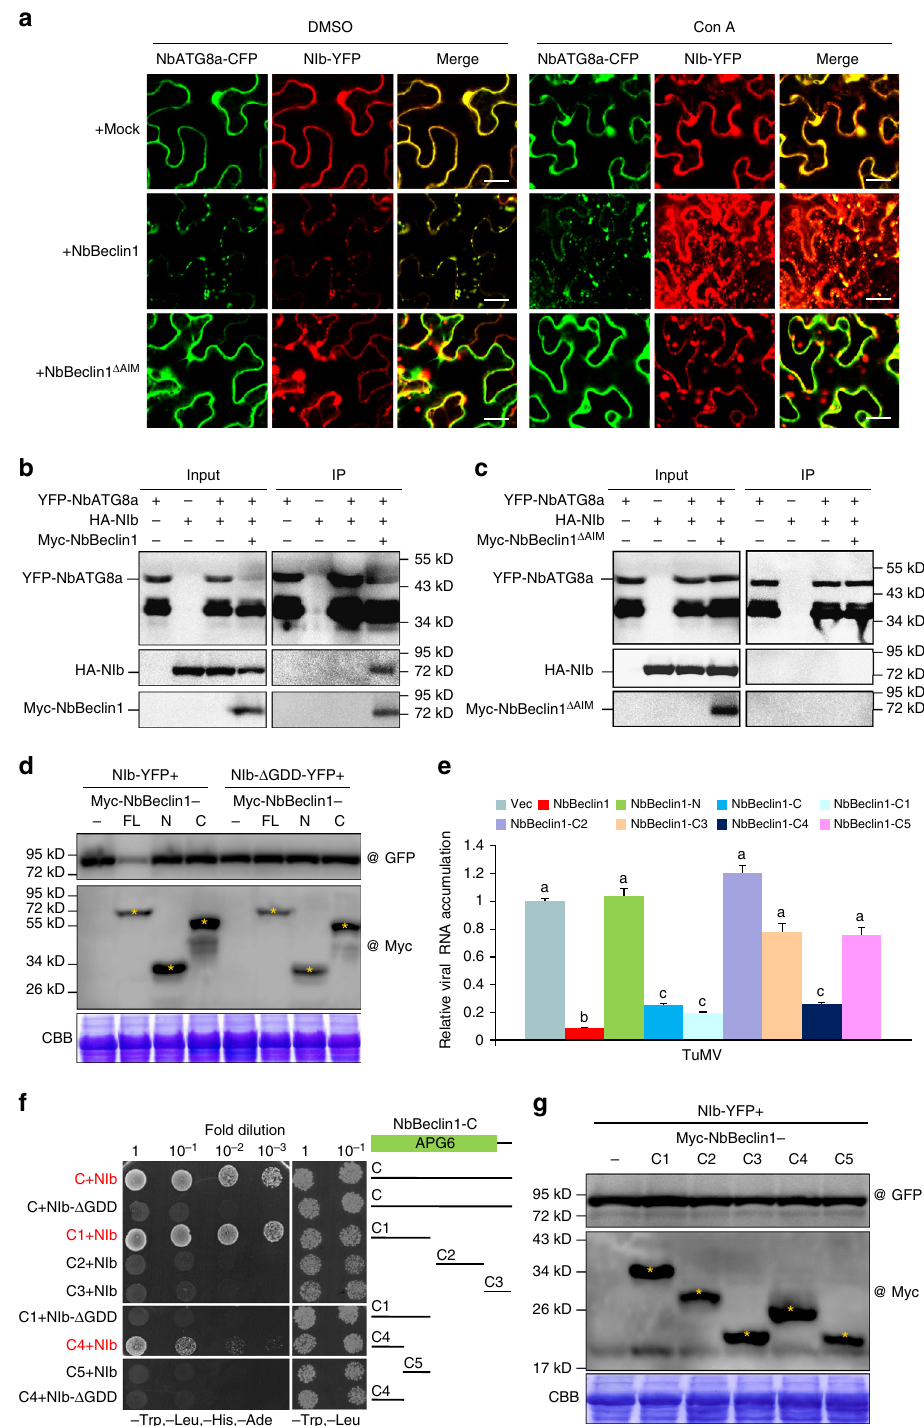
Fig. 7f, the NIb-binding motif was mapped to the N-terminal region (C1) of NbBeclin1-C (strong interaction) or the N- terminal half (C4) of C1 (weak interaction). As expected, both C1 and C4 were unable to mediate NIb degradation (Fig.